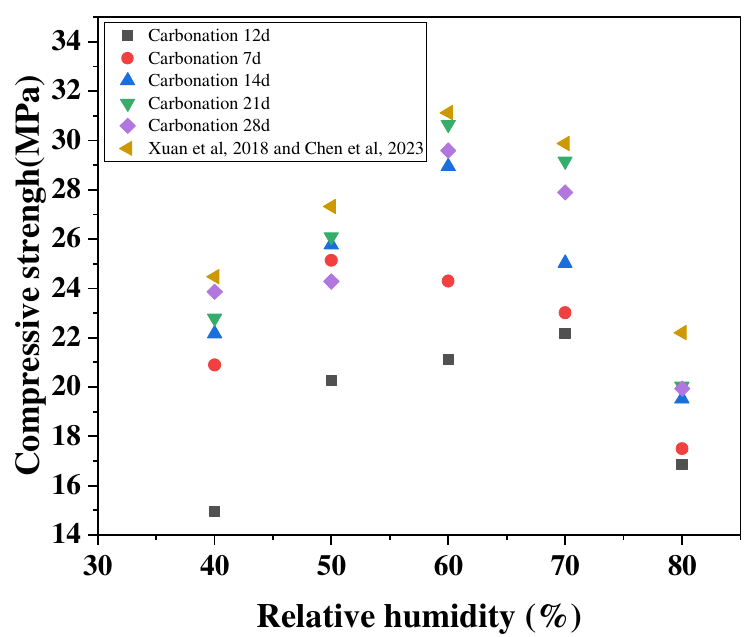
Figure 7. Effect of relative humidity on conservation with carbonation [46,53].